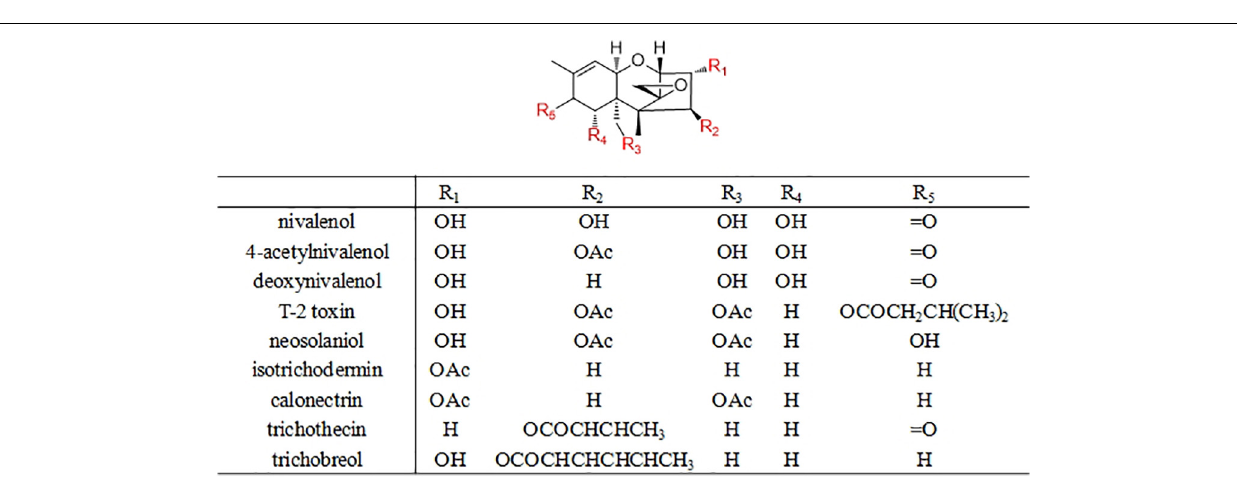
FIGURE 9 | Representative antifungal trichothecene sesquiterpenes